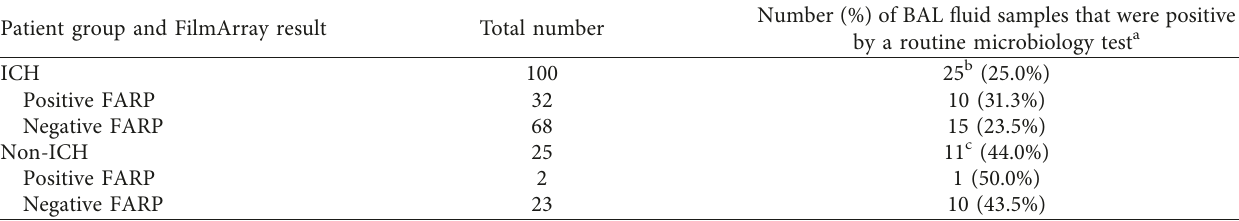
Table 5: Yield of routine microbiology studies in bronchoalveolar lavage fluid collected from immunocompromised ( n � 100) and immunocompetent ( n � 25)